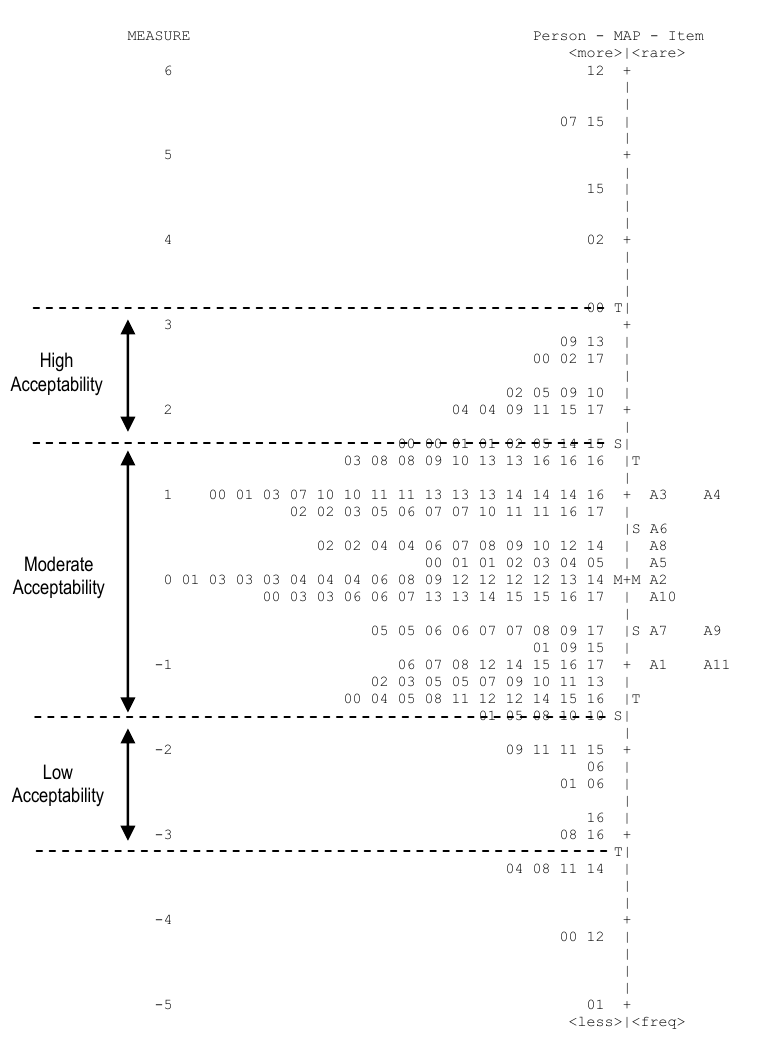
Figure 3 Wright Map of Online Counseling